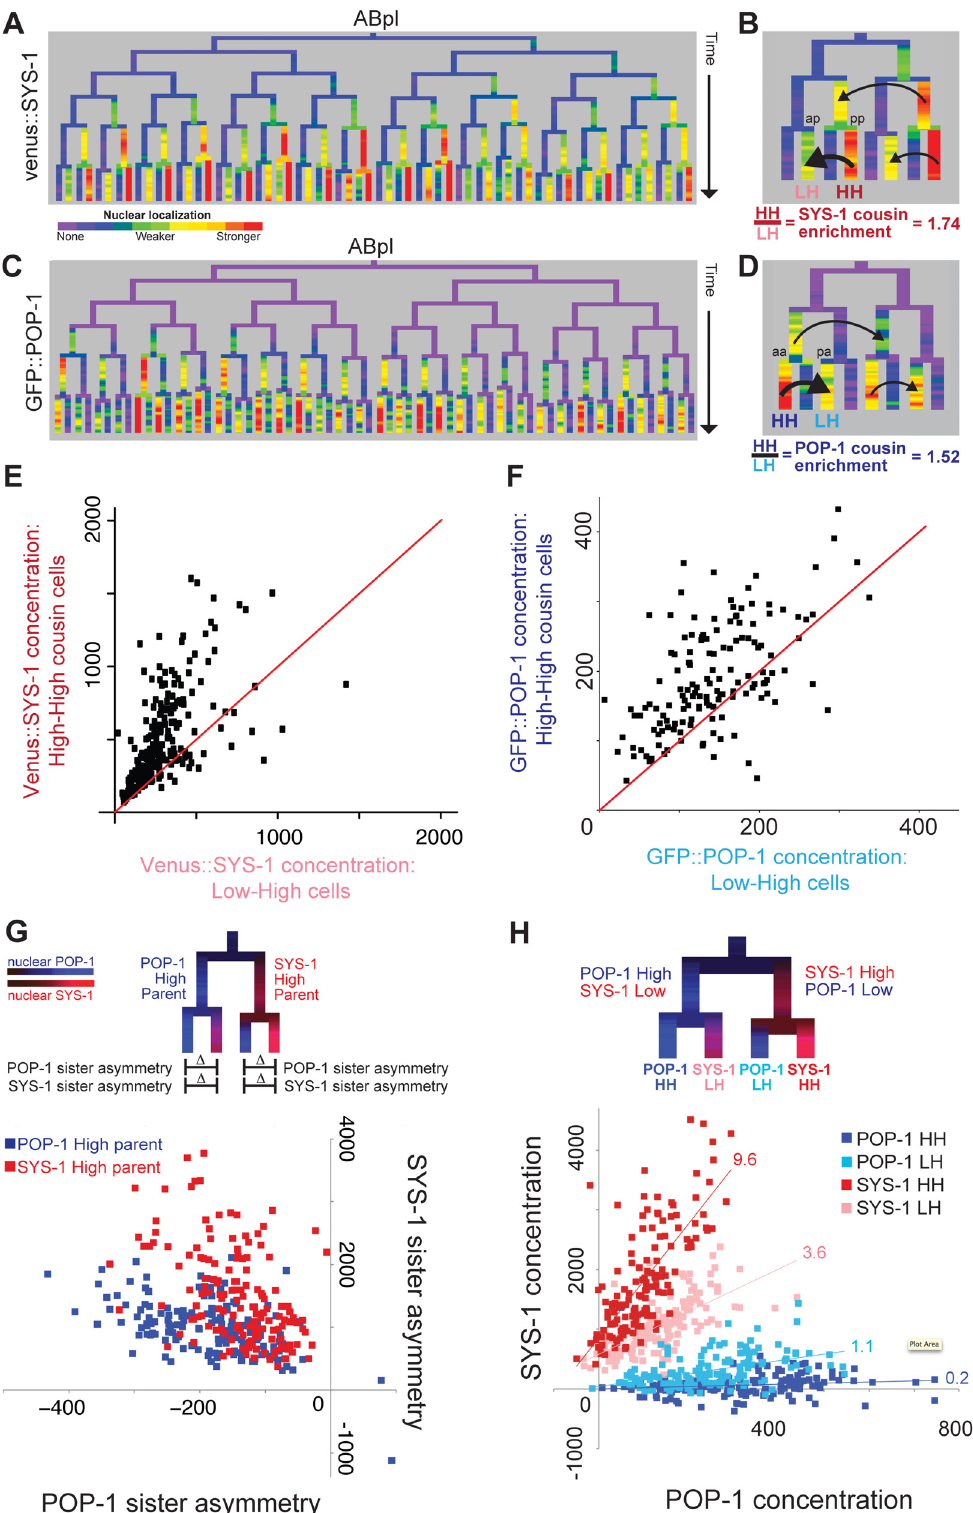
Fig 3. β -catenin and TCF show enrichment when localized to the nucleus in successive cell cycles. A) Nuclear localization of Venus::SYS-1 in the ABpl lineage, shows the highest level in cells derived from consecutive posterior parents. B) Detail showing ABplaaa lineage; Black arrows show